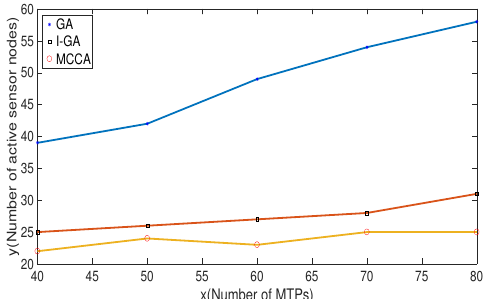
Figure 10. Comparison of the number of activated sensor nodes for different numbers of monitored target points (MTPs).